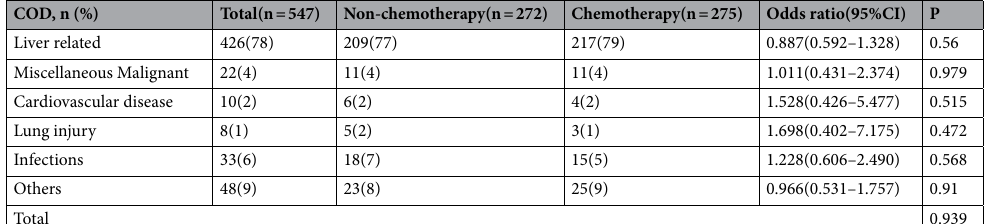
Table 5. Comparision of causes of death in HCC patients with chemotherapy and without chemotherapy. *Two-sided P values < 0.05. **Two-sided P values < 0.01. ***Two-sided P values < 0.001. COD, cause of death.